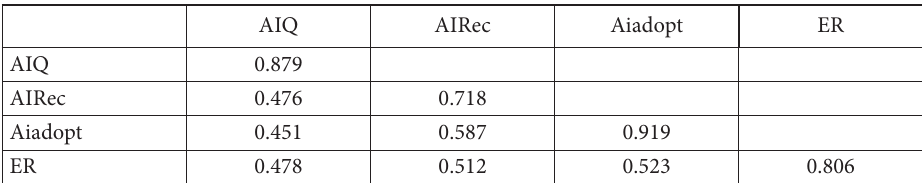
Table 2. Discriminant